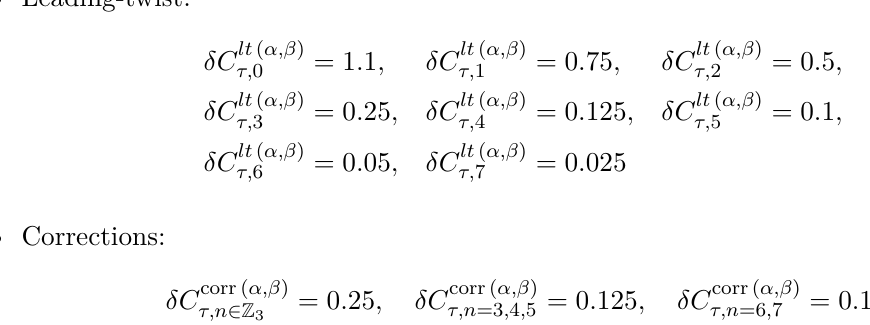
p Cov Cov ij / ii jj